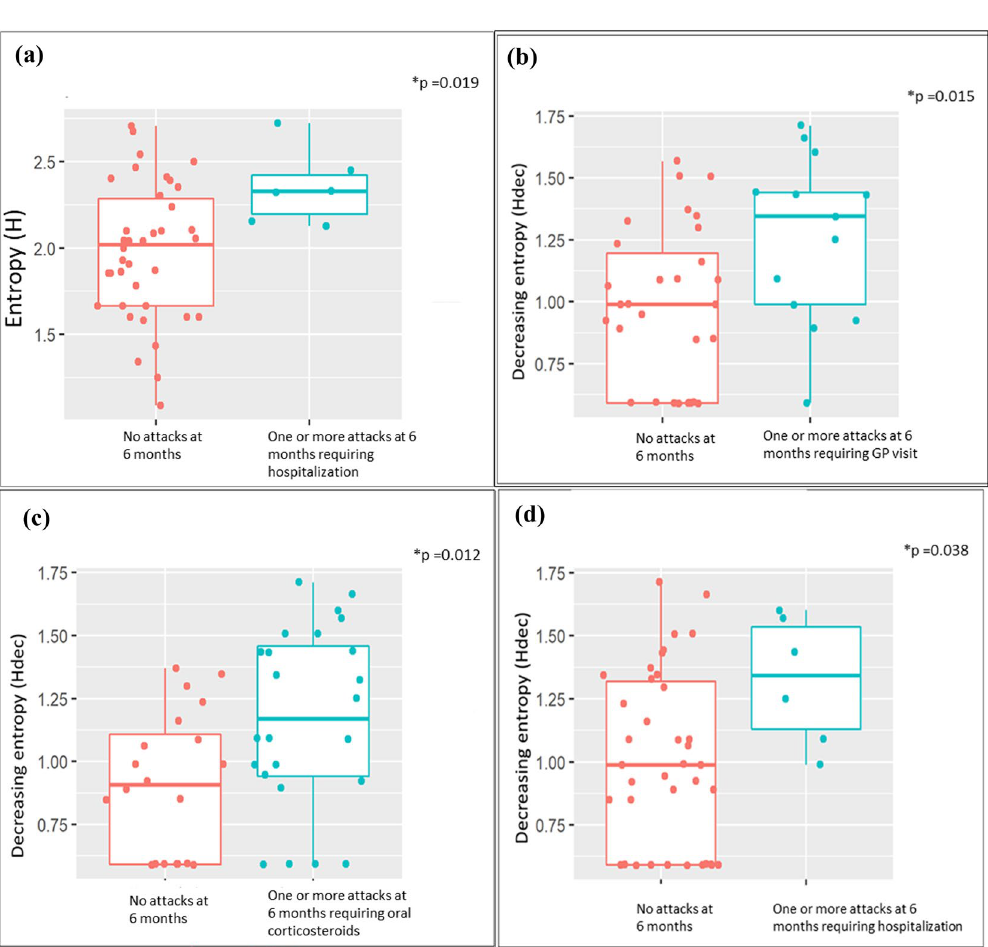
Figure 5. Entropy metrics (over day 0–50) predict asthma outcomes (over days 0–180). Panel ( a ): Entropy (H) and attacks requiring hospitalisation. Panels ( b – d ): Decreasing entropy (H dec ) and attacks requiring general practitioner (GP) visit, oral corticosteroids or hospitalisation respectively. The boxes depict the 25th, 50th, and 75th percentiles while the whiskers depict the minimum and maximum values in the data. The individual data points are also shown as dots. (R version 3·3 https:// www.R- proje ct.